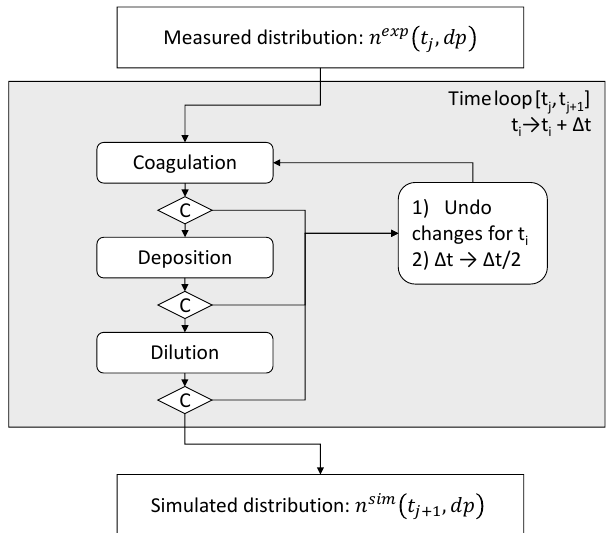
Figure B1. Flow diagram of the aerosol dynamics model calculat- ing the changes to a particle size distribution n exp (t j ,d p ) within the time interval [ t j ,t j + 1 ]. C stands for control parameter and t stands for